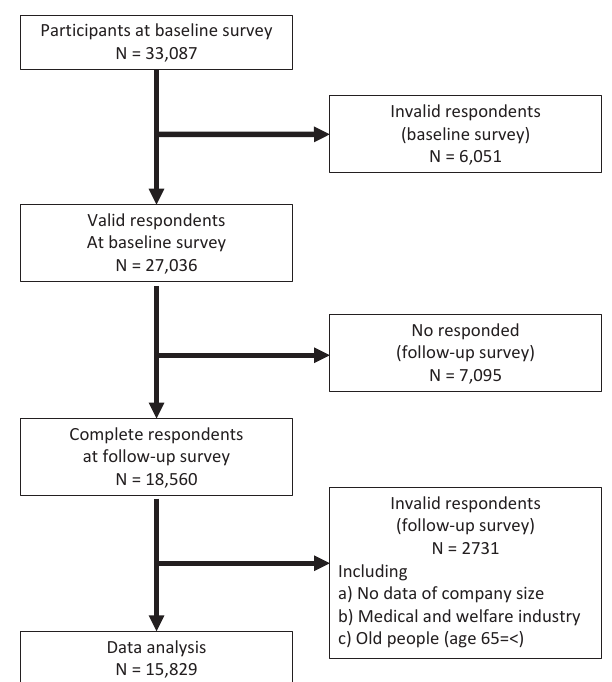
Fig. 1 Flow diagram of the study